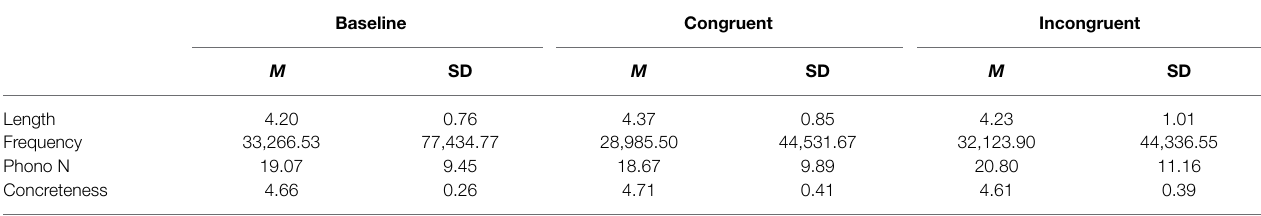
TABLE 1 | Means and standard deviations of lexical characteristics of target words across conditions.